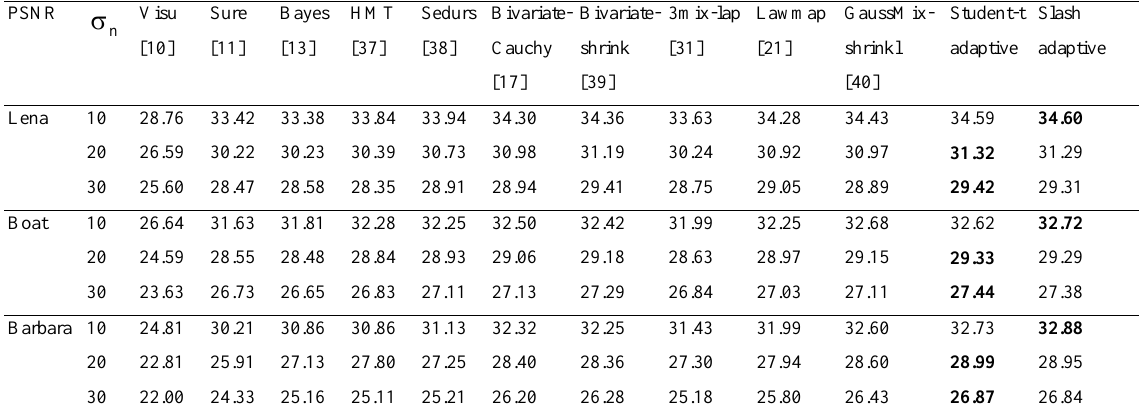
Table 2. Comparison of performance for image denoising using different algorithms and orthogonal wavelet transform